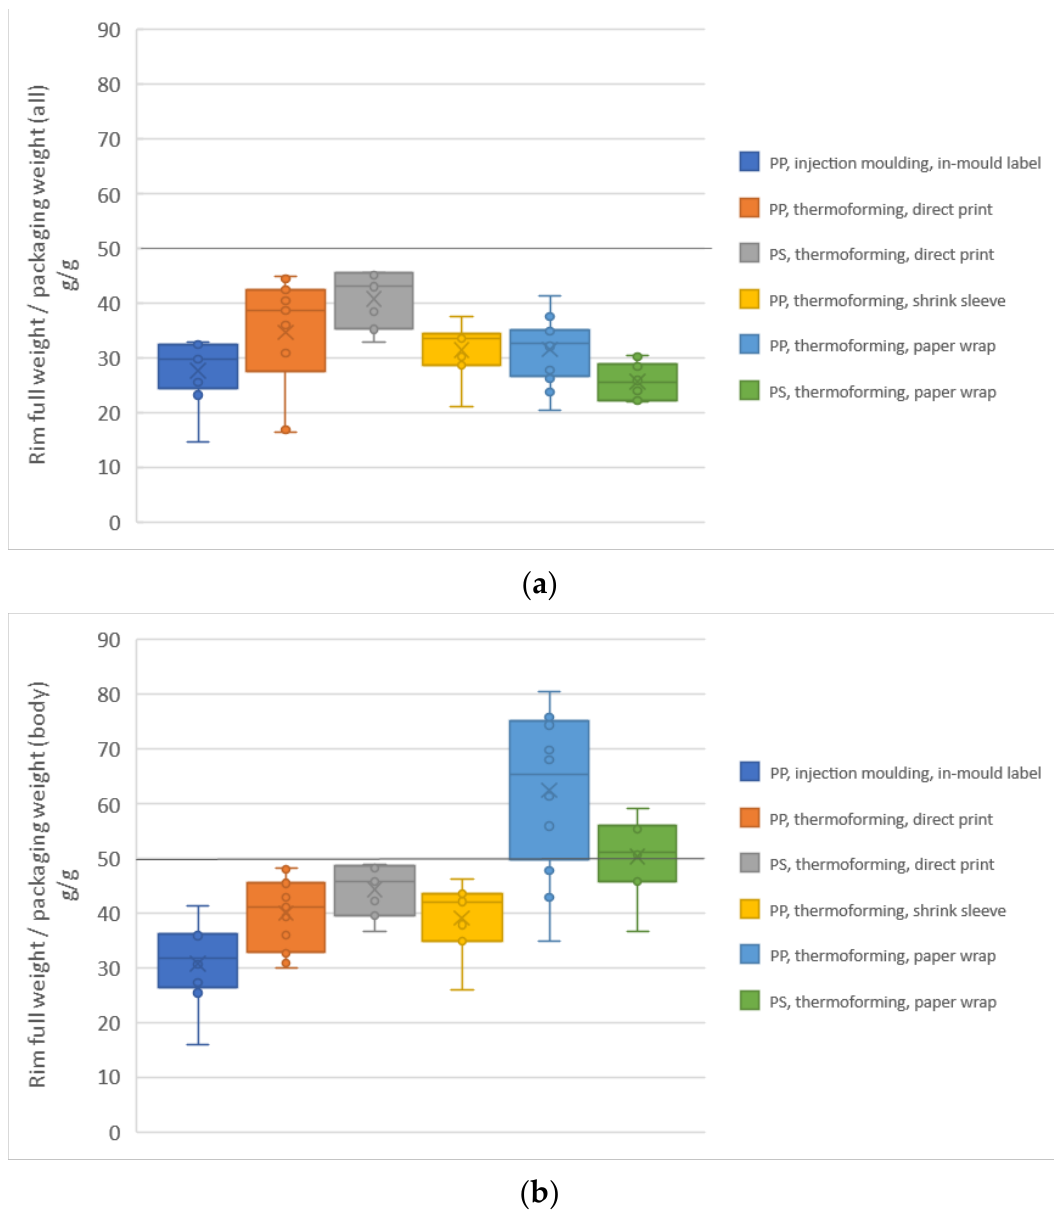
Figure 15. Packaging efficiencies (rim full weight divided by packaging weight; packagings filled with water) for different types of packaging, ( a ): all packaging components included (with labels, wrappings, shrink sleeves if applicable), ( b ): only body (separatable components are excluded) .